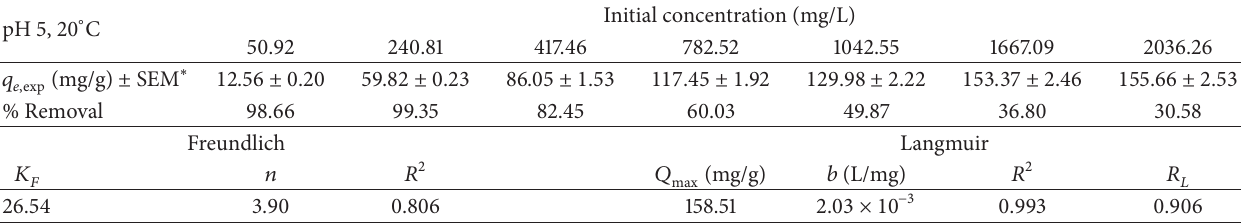
Table 8: Removal capacities and adsorption isotherms constants of Pb (II) at different initial